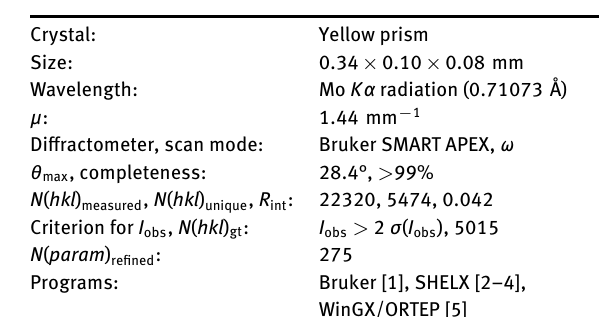
Table 1: Data collection and